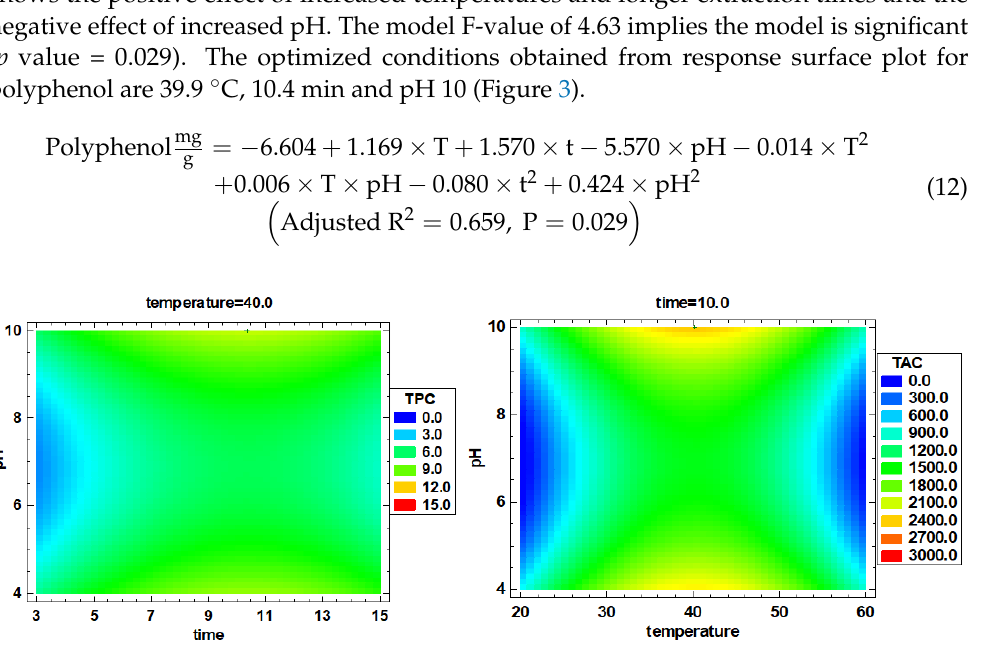
Figure 3. Estimated response surface of total polyphenol content and total antioxidant capacity. TPC (mg/g) and TAC corresponding to total polyphenol content and total antioxidant capacity (µM TE).